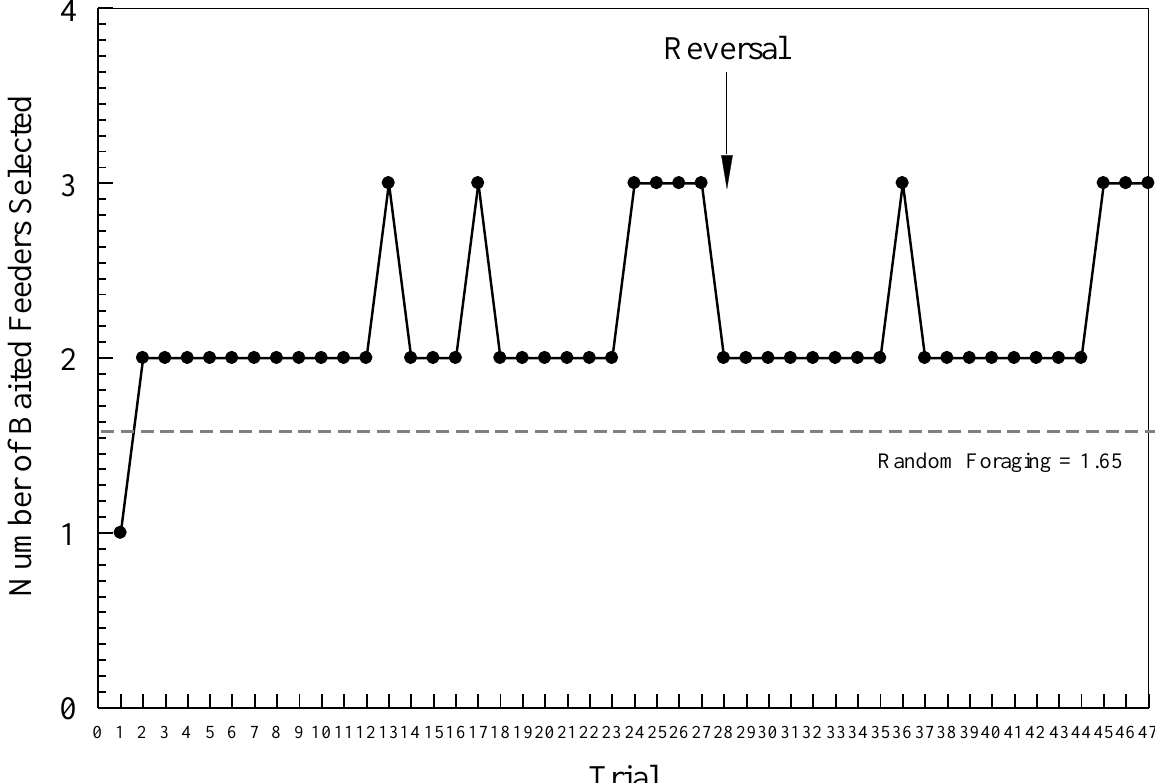
Figure 2 . Male B success in first four